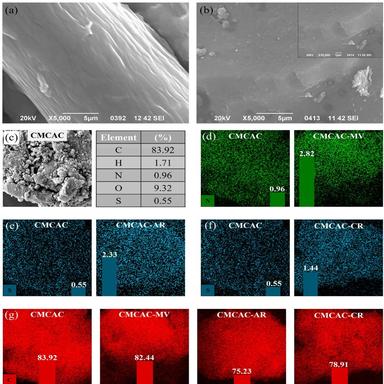
SEM images of (a) CMC and (b) CMCAC where the inset in (b) is the partially magnified image; (c) C, H, N, O, S content of CMCAC; EDS-mapping for (d) N content of CMCAC and CMCAC-MV, (e) S content of CMCAC and CMCAC-AR, (f) S content of CMCAC and CMCAC-CR, (g) C content of CMCAC, CMCAC-MV, CMCAC-AR and CMCAC-CR.